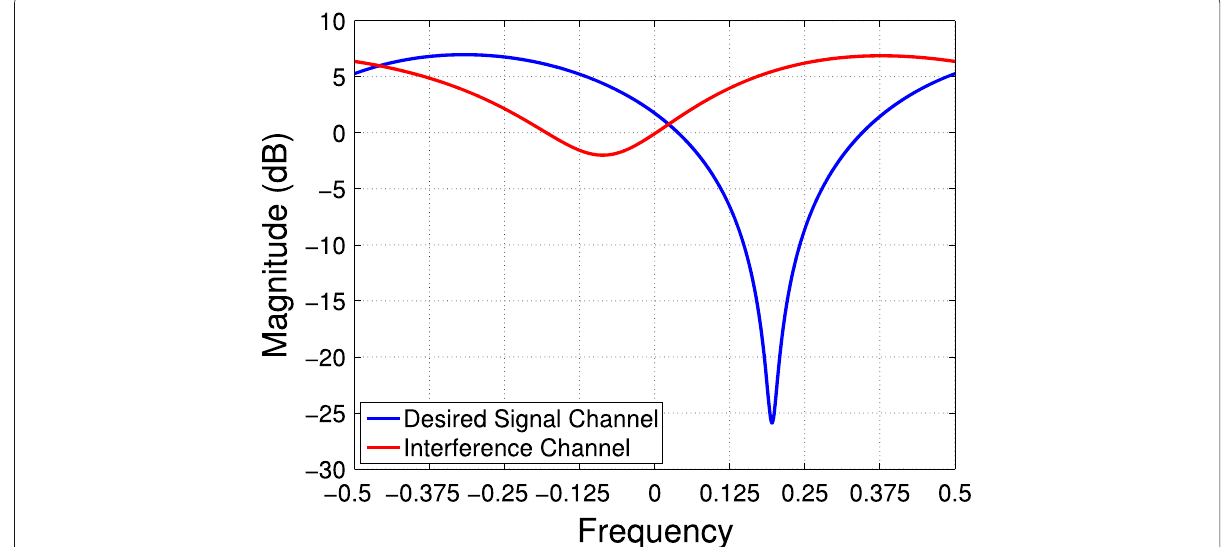
Fig. 10 The magnitude of the frequency response for the channel on the desired signal and